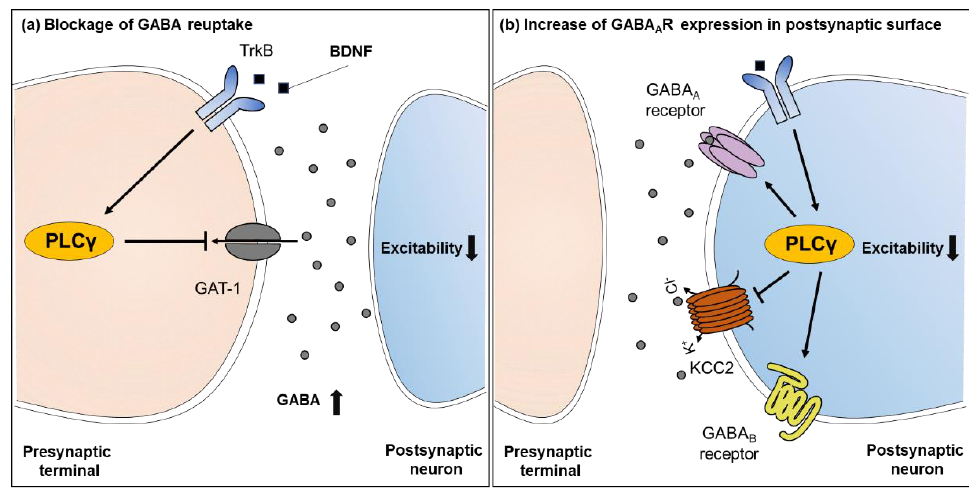
Figure 3. The functions of PLC γ in GABAergic inhibition. ( a ) Activation of PLC γ by the BDNF/TrkB pathway prevents GABA reuptake by GAT-1, leading to the accumulation of extracellular GABA. ( b ) Activation of PLC γ increases the surface expression of GABA A receptors. In addition, PLC γ inhibits Cl – extrusion via the regulation of KCC2 function. Activation of GABA B receptors induces BDNF secretion through PLC γ activation and consequently increases the expression of GABA A receptors in the postsynaptic membrane, therefore decreasing the excitation of neurons.